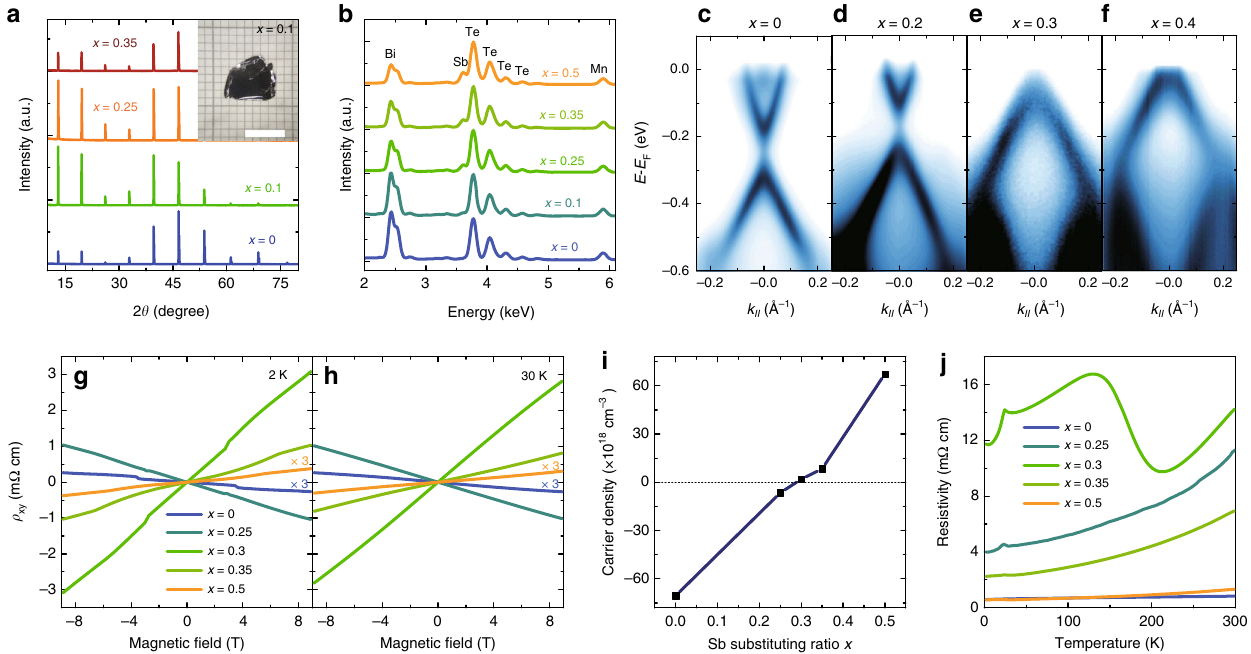
Fig. 2 Crystal characterization and n – p transition in Mn(Sb x Bi (1 − x ) ) 2 Te 4 . a Single crystal XRD pattern for samples with different antimony substitutions. Scale bar: 5 mm. b EDS curves of the fi ve samples for x = 0 to 0.5. The curves are offset for clarity. c – f ARPES measurements for the samples with different antimony substituting ratio. g , h Measurements of Hall resistivity ρ xy as a function of the magnetic fi eld in samples with different values of x at 2 and 30 K, respectively. i Corresponding carrier density of samples with different x derived from the Hall resistivity in e . j Resistivity versus temperature of samples for various values of